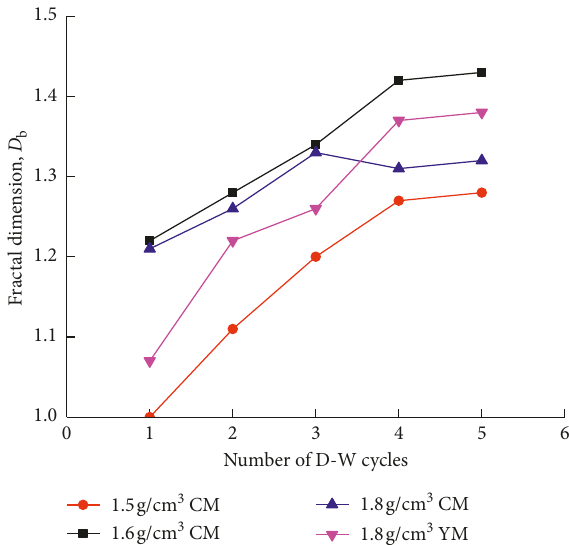
Figure 4: Variations of fractal dimension with the number of D-W cycles.